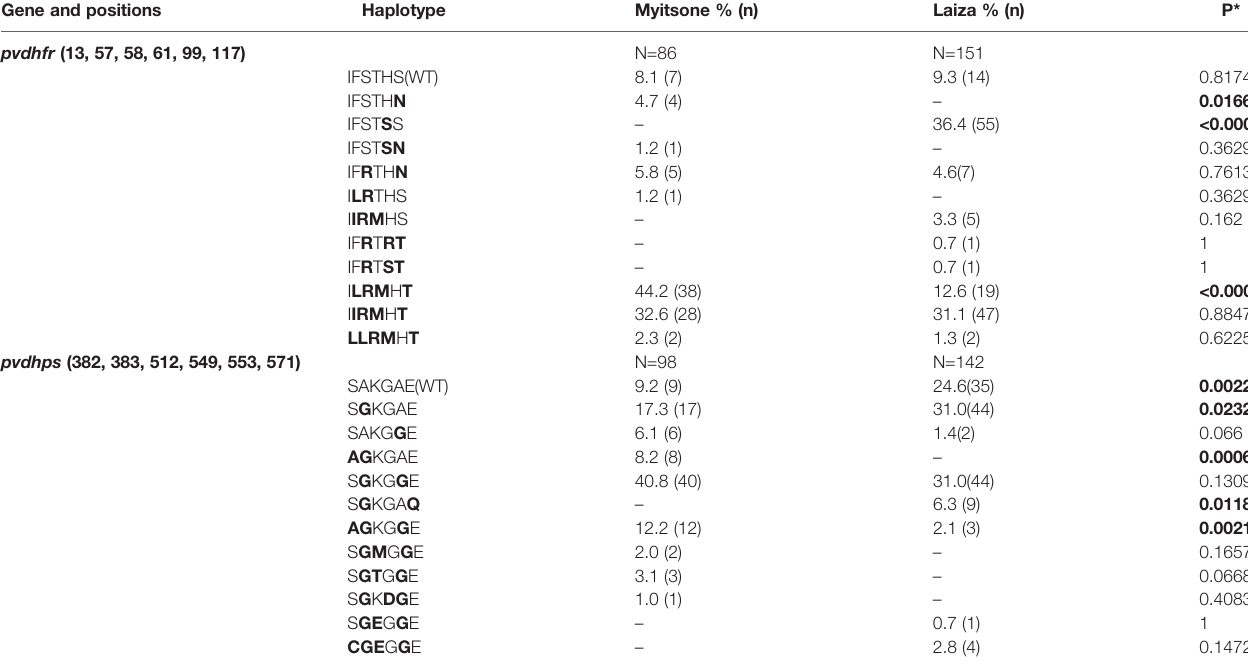
TABLE 3 | Prevalence of pvdhfr and pvdhps haplotypes in two sites Gene and positions